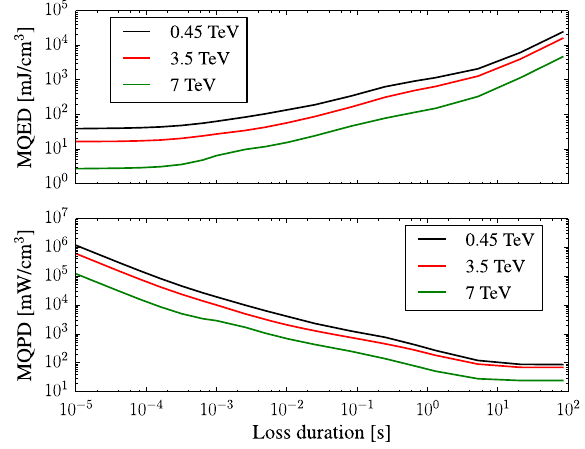
FIG. 2. MQED (up) and MQPD (down) as a function of beam-loss duration for heat pulses of constant power. The quench levels are computed with QP3 [9] on the horizontal plane of a main-dipole magnet, for the geometrical loss pattern of [10], with magnet currents corresponding to injection beam energy (450 GeV), 3.5 TeV, and 7